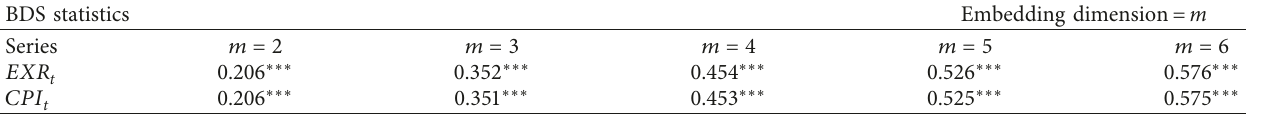
Table 3: Results of BDS nonlinearity test.